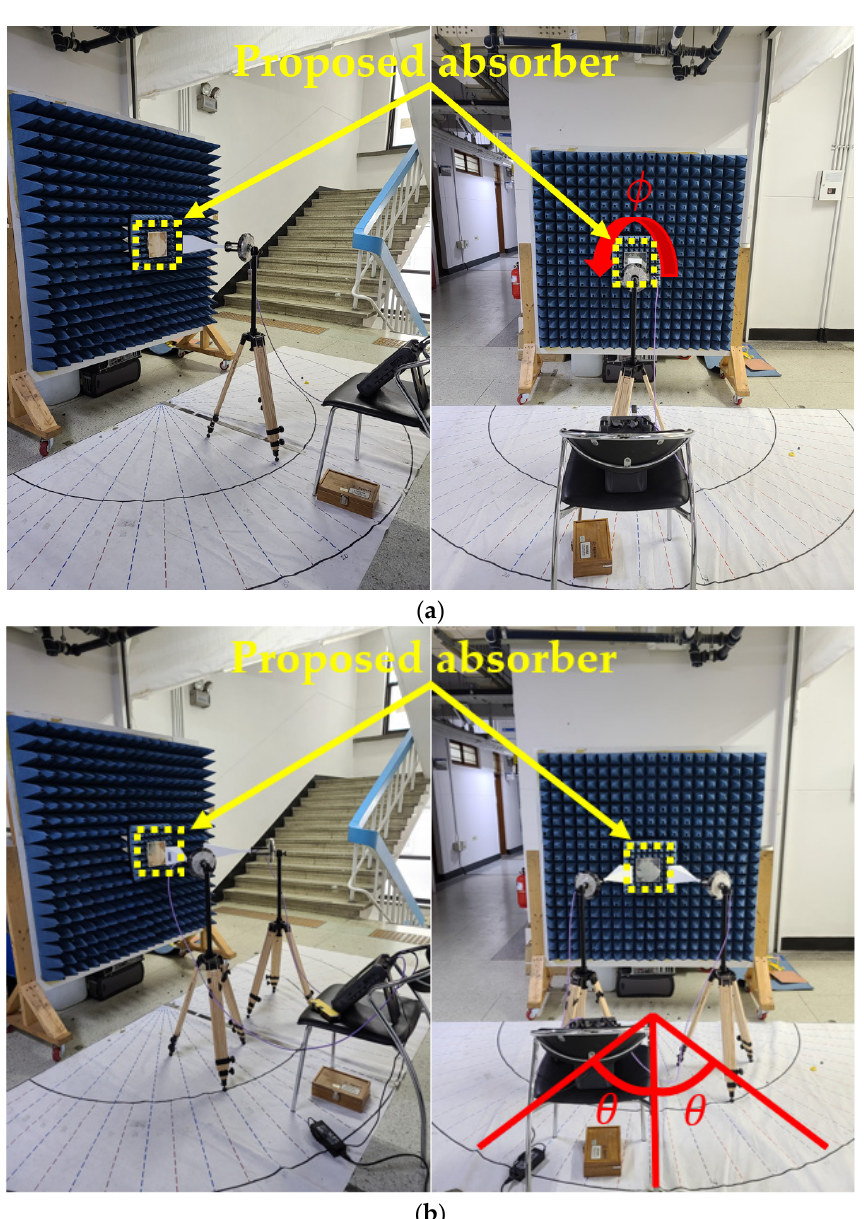
Figure 8. Measurement setup. ( a ) For various polarizations, and ( b ) for various incidence angles (TE and TM modes).